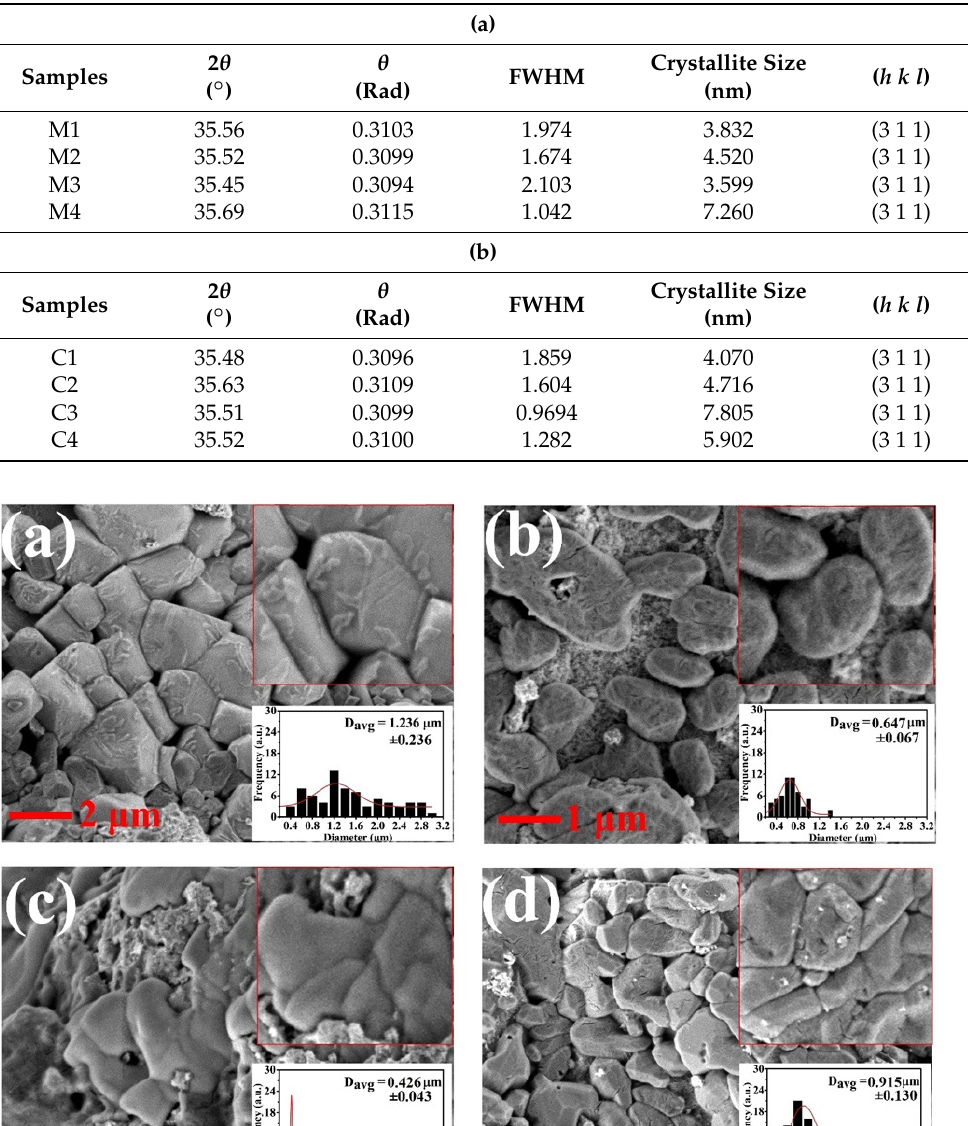
Table 2. ( a ) Brag’s angles, FWHM and crystallite sizes for samples M1 to M4. ( b ) Bragg’s angles, FWHM, and crystallite sizes for samples C1 to C4.